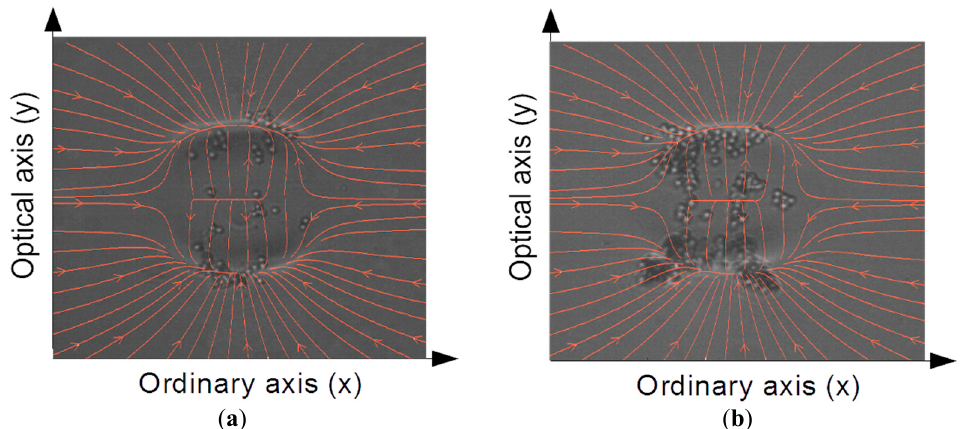
Figure 5. Two example of superposition of numerical simulation results and the experimental images obtained for PMMA spheres in paraffin oil, ( a ) and ( b ) were obtained by repeating the same experiment twice while increasing the beads density.